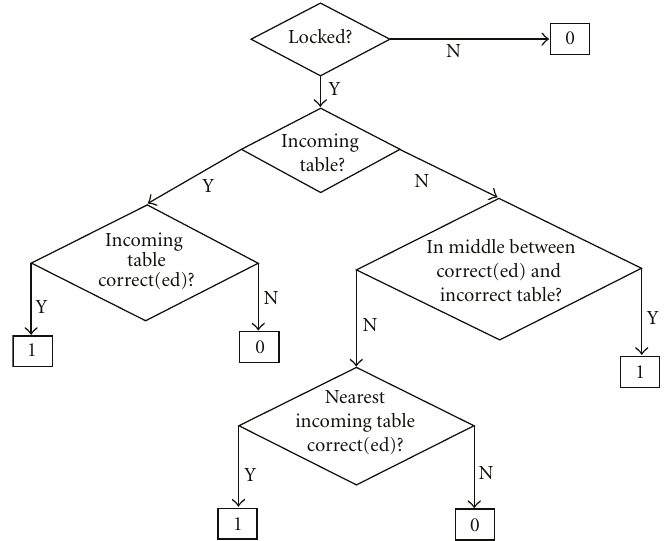
Figure 3: Flow graph illustrating the labeling of the samples (0 or 1) (Y = yes, N = no). Table 1: Parameter sets investigated to determine the influence of MPE-FEC and modulation